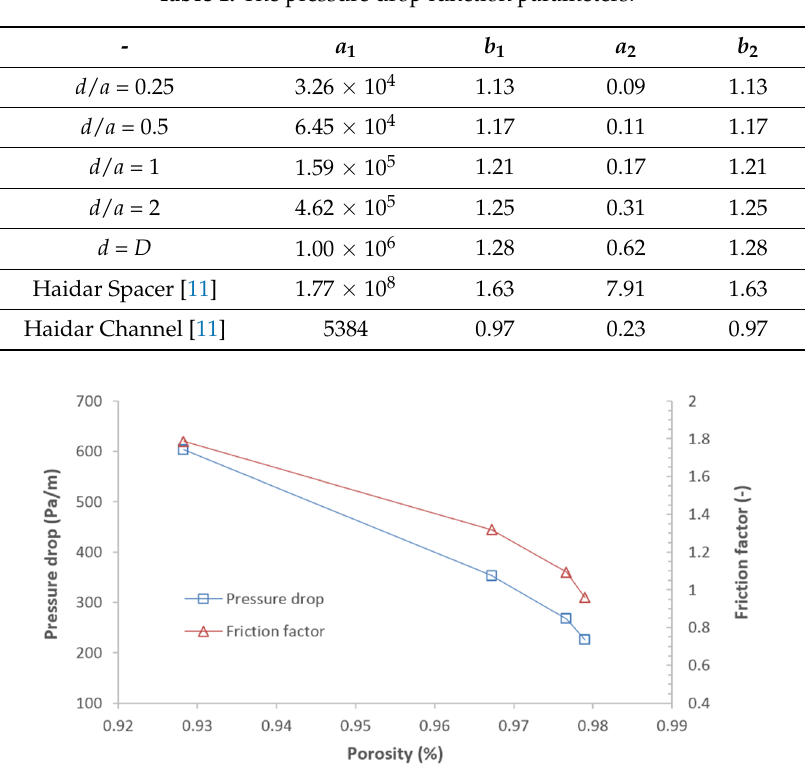
Figure 7. The pressure drop and friction factor as a function of channel porosity for the inlet velocity at 0.04 m/s (at a constant flow rate).